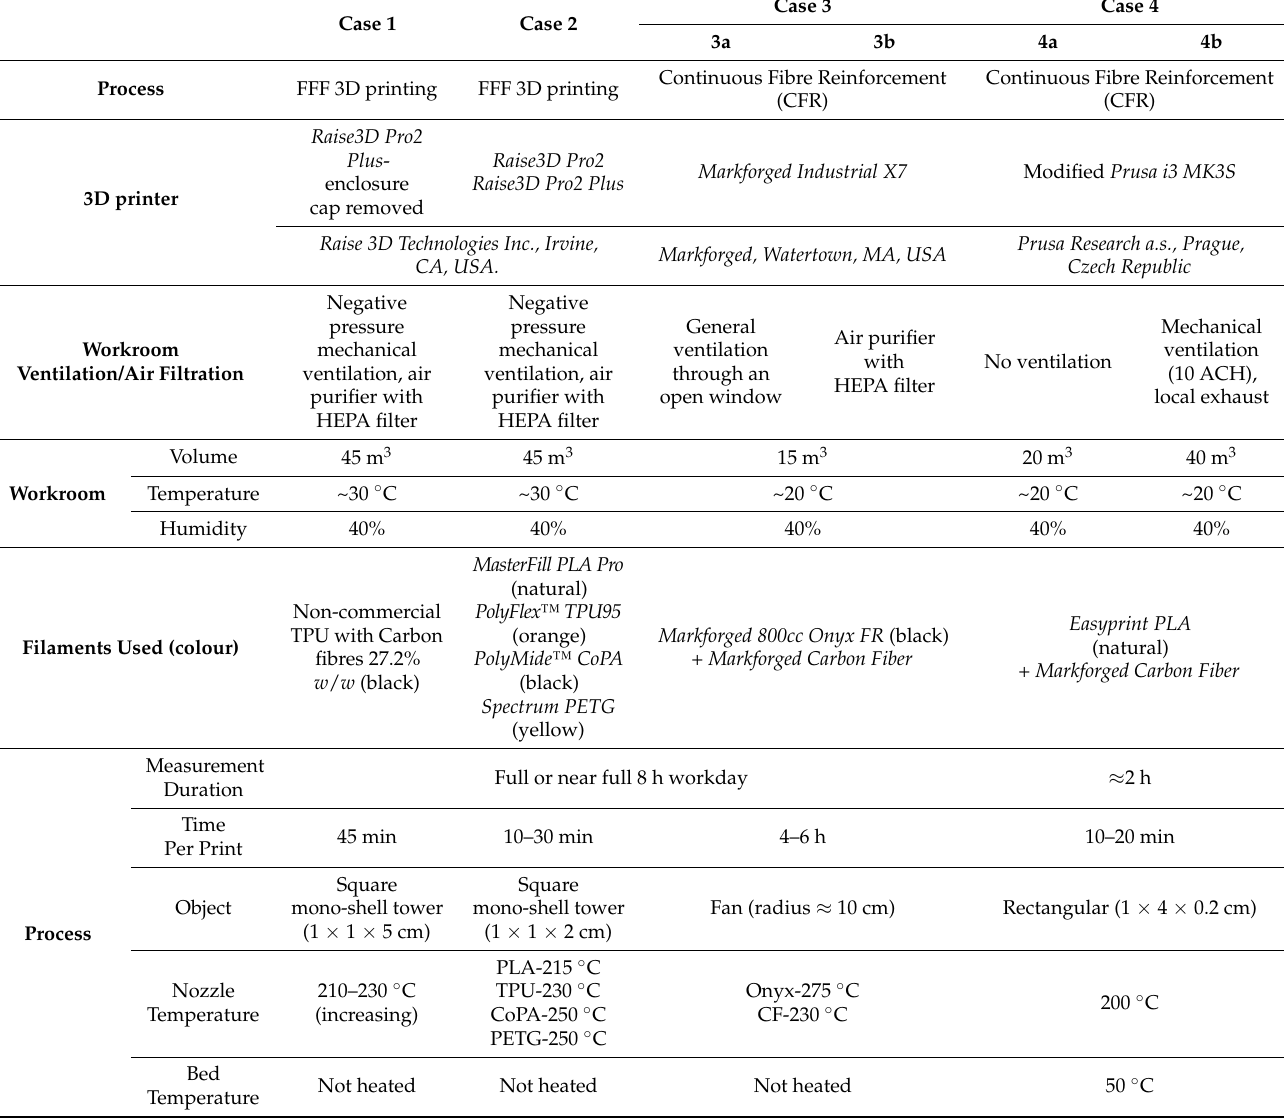
Table 1. Information gathering as a pre-assessment in 3D printing processes exposure